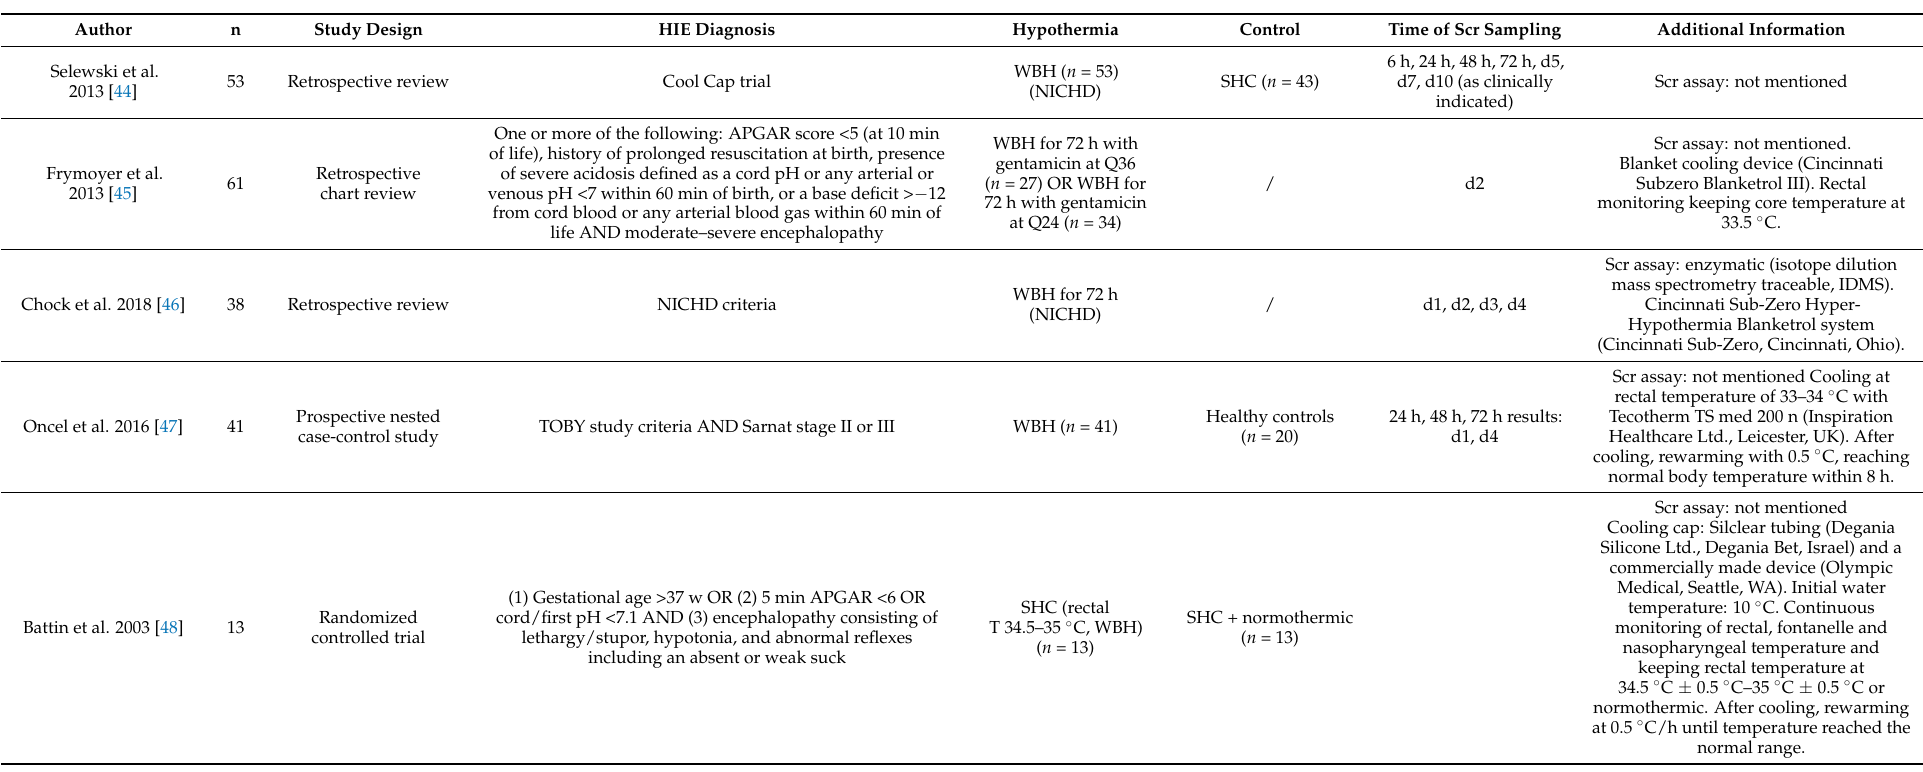
Scr assay: not mentioned Cooling at rectal temperature of 33–34 ◦ C with Tecotherm TS med 200 n (Inspiration Healthcare Ltd., Leicester, UK). After cooling, rewarming with 0.5 ◦ C, reaching normal body temperature within 8